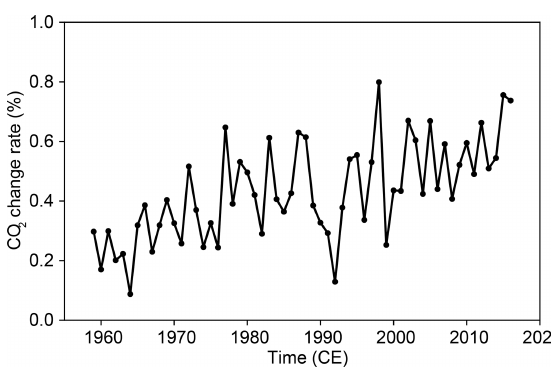
Figure 1. Historical yearly rate of atmospheric CO 2 change derived from the Mauna Loa record (Trans and Keeling, 2017). Note that the annual rate of increase has never breached 1% a year and has averaged 0.46%a − 1 over the historical